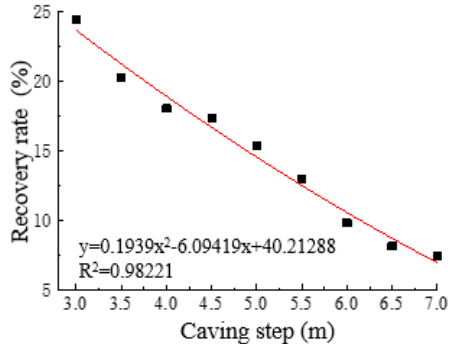
Figure 12. Relationship between ore dilution ratio and caving step.